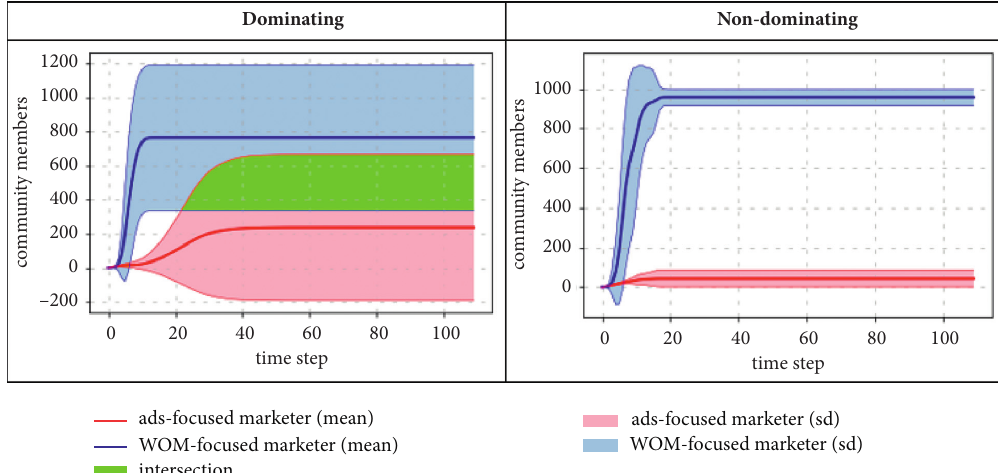
Figure 17: Simulation result for dominating and nondominating OAF for the Bass diffusion